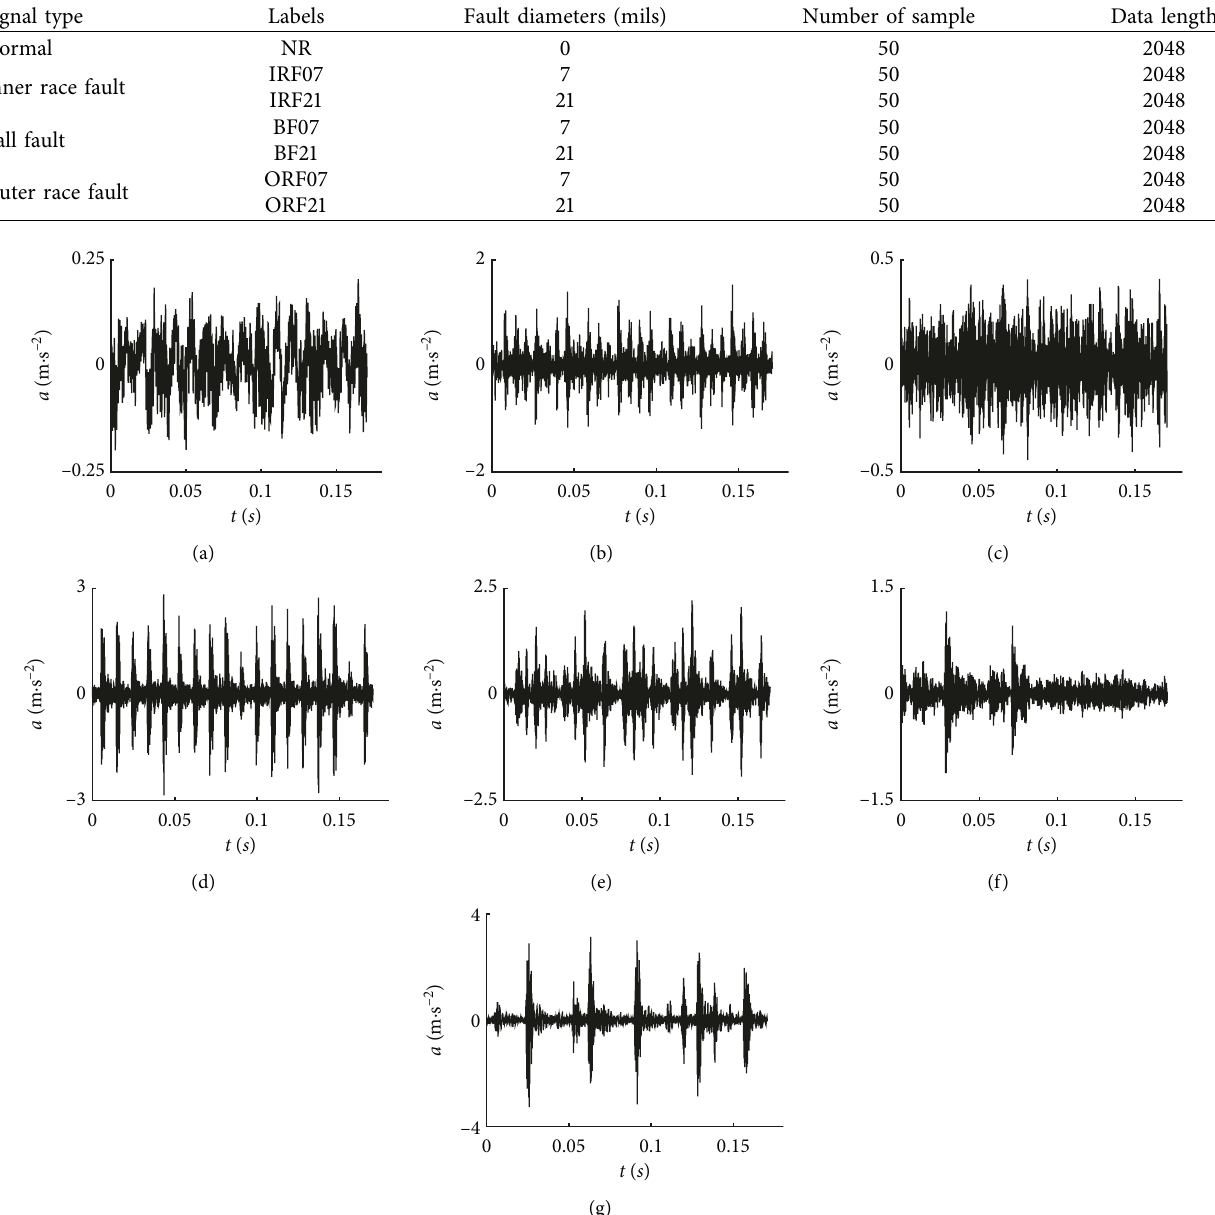
Figure 6: Time-domain vibration signals for rolling bearing under various working states: (a) NR; (b) IRF07; (c) BF07; (d) ORF07; (e) IRF21; (f) BF21; (g) ORF21.